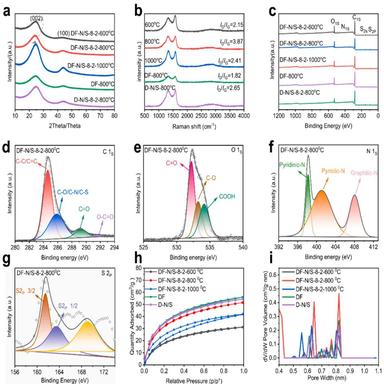
(a) XRD pattern of DF, D-N/S and DF-N/S; (b) Raman spectra of DF, D-N/S and DF-N/S; (c) The rough XPS scanning spectra of DF, D-N/S and DF-N/S; The high-resolution XPS for DF-N/S-8–2-800℃ of (d) C 1 s, (e) O 1 s, (f) N 1 s and (g) S 2p; (h) CO2 adsorption–desorption isotherms; (i) Pore size distribution of all materials.